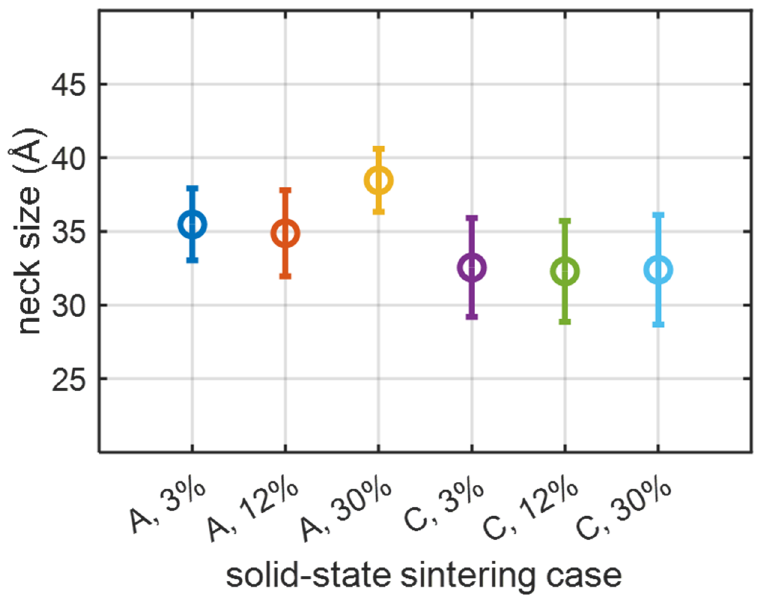
Figure 4. Neck size measurement for every neck connection of each simulated model after the solid-state sintering process.